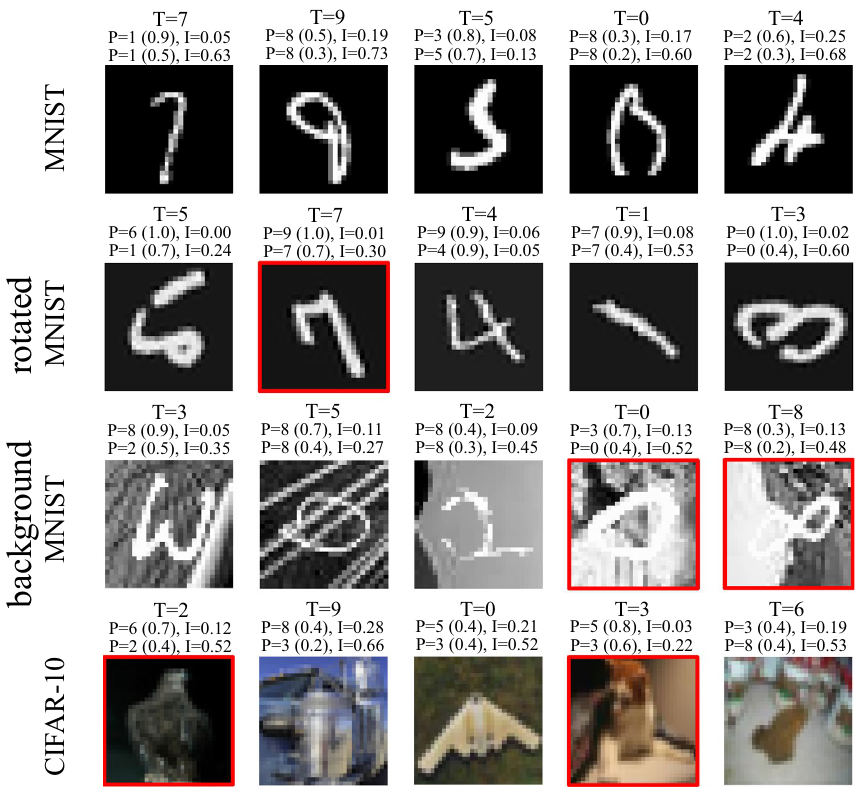
Figure 3. Sample model prediction and uncertainty estimation results on MNIST, rotated MNIST, background MNIST, and CIFAR-10 datasets. T: ground-truth label, P: model prediction (with the average MC prediction probability of the predicted class provided in the parentheses), and I: model uncertainty estimation. For each sample, the second and third line of the provided information are corresponding to MC-Dropout and MC-DropConnect respectively. The red boundary around images highlights correct-uncertain predictions of MC-DropConnect method.